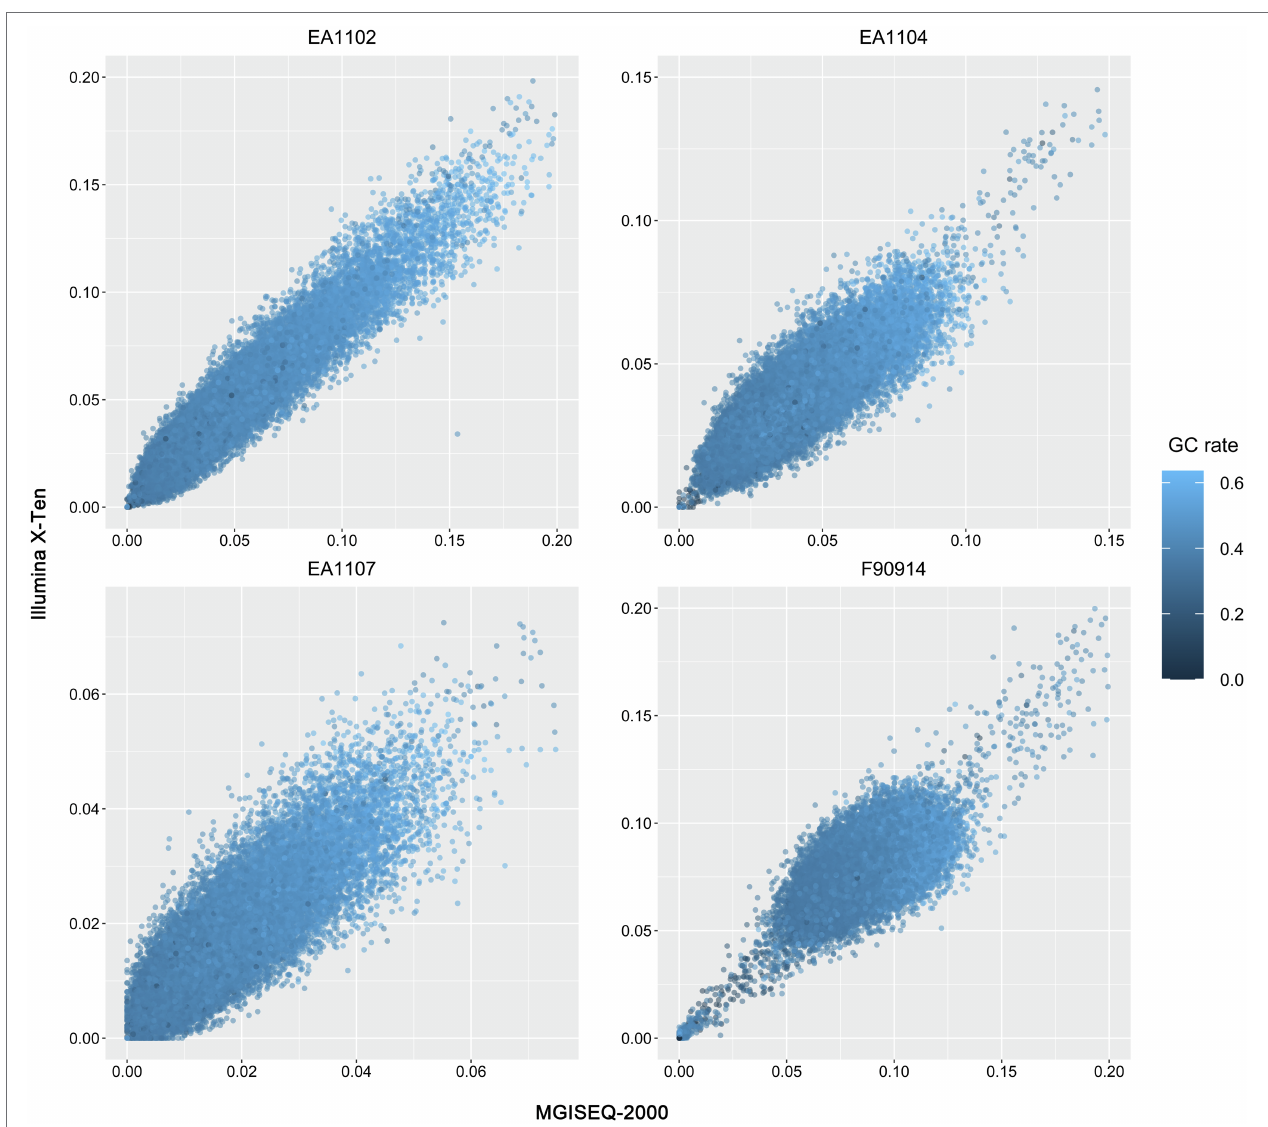
FIGURE 3 | The dot plots of sequencing coverage rate of MGISEQ-2000 vs. Illumina X-Ten in 100-kb windows. The color of each dot represents the GC content in each